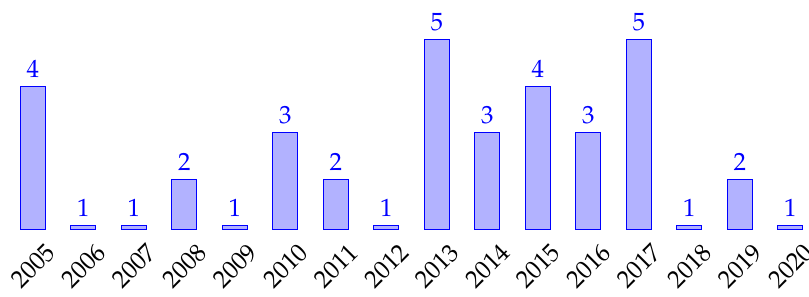
Figure 8. Distribution of primary studies by